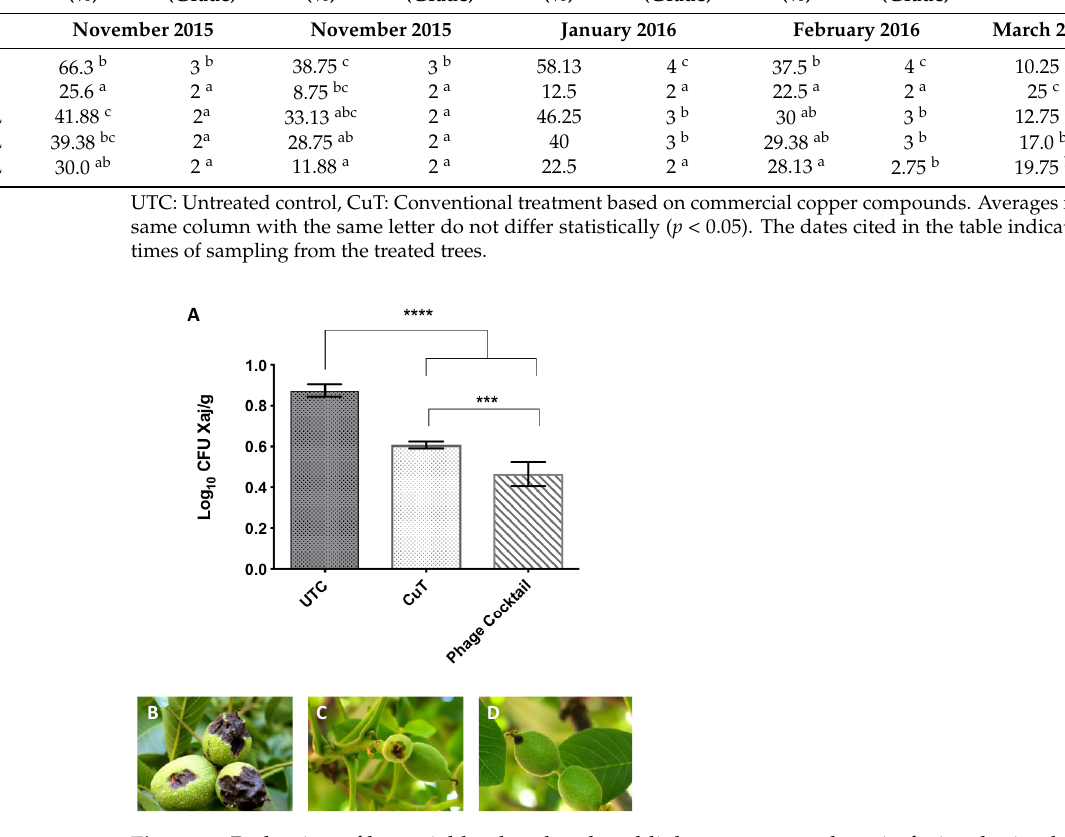
Figure 7. Reduction of bacterial load and walnut blight symptomatology in fruits obtained from treated fields. ( A ) Bacterial load (CFU/g) on walnut fruit post-treatments. UTC: Untreated control, CuT: Conventional treatment based on commercial copper compounds. Error bars represent standard deviation of three groups of tree walnut fruit from each treatment. Highly significant (****) different from the UTC ( p < 0.0001); Significantly (***) different between groups. ( p < 0.001). Representative images of immature walnut fruit post-treatment: ( B ) UTC, ( C ) CuT, and ( D ) phage cocktail (4 cc/L).